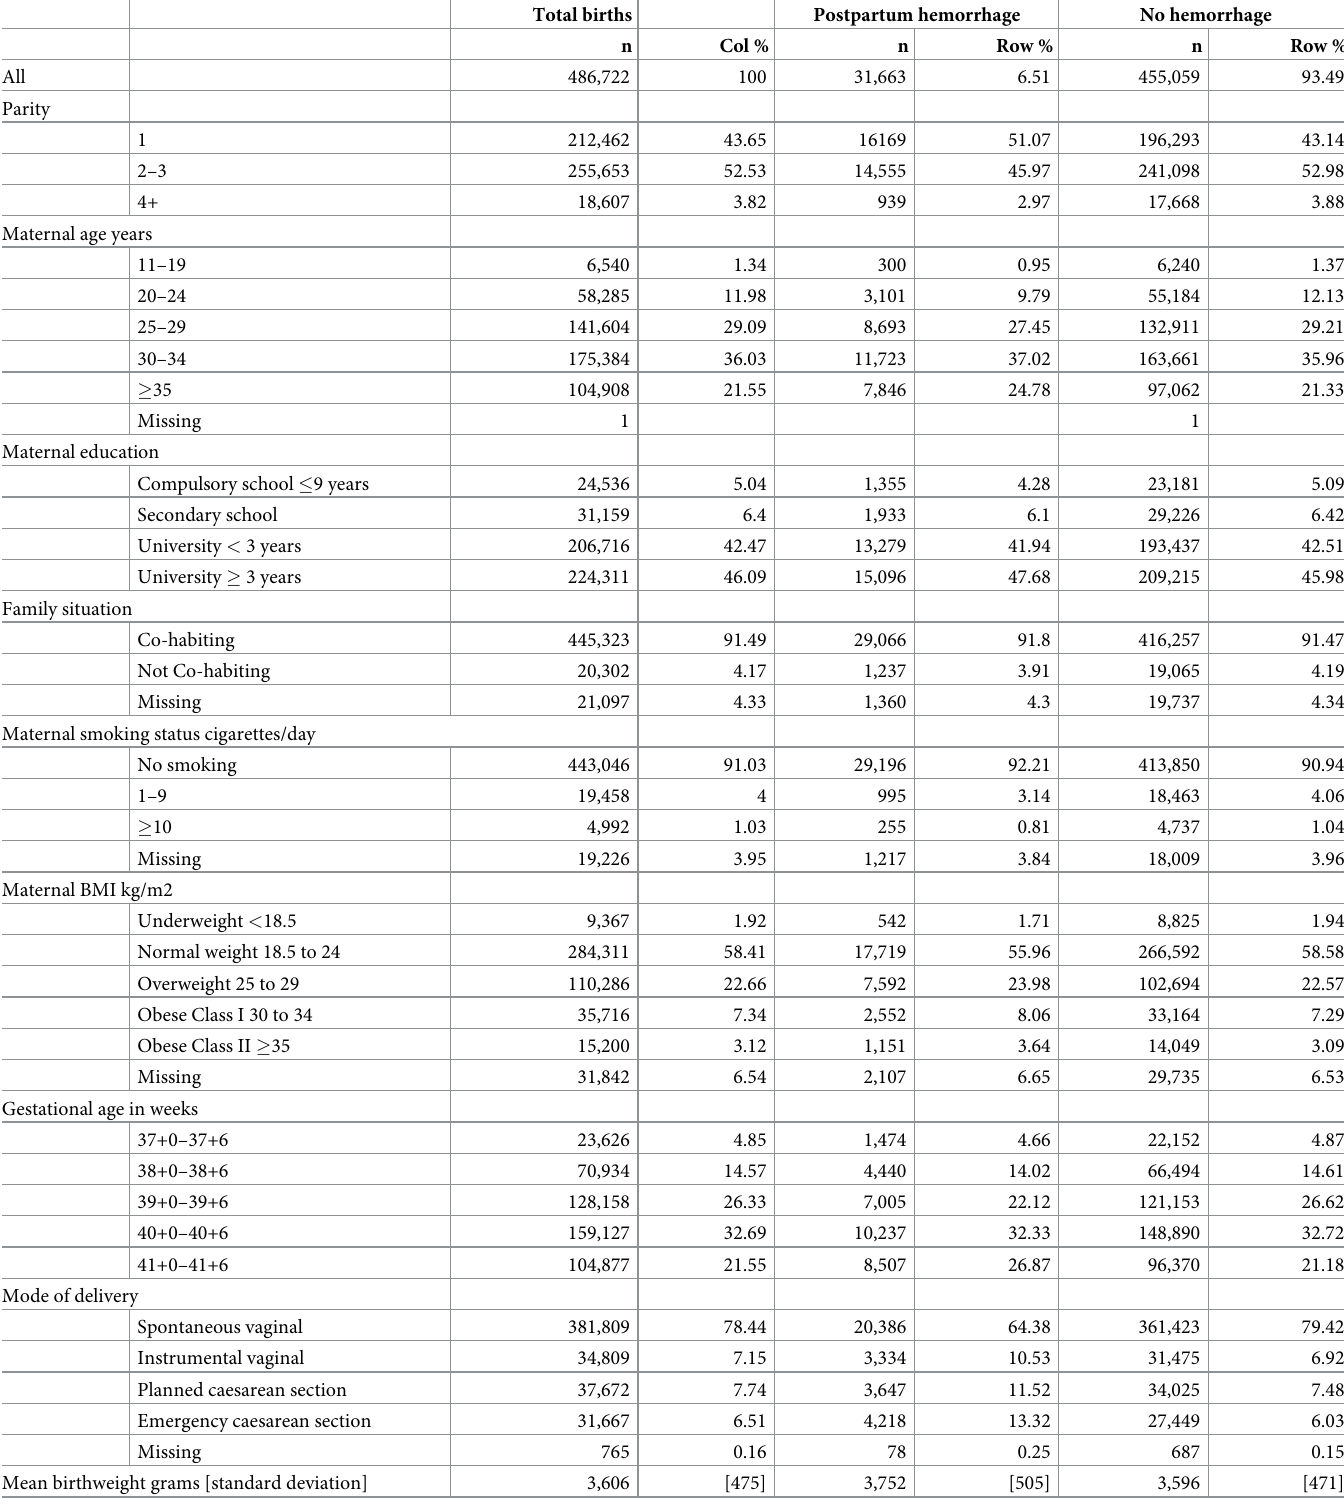
Table 1. Maternal and obstetric characteristics.